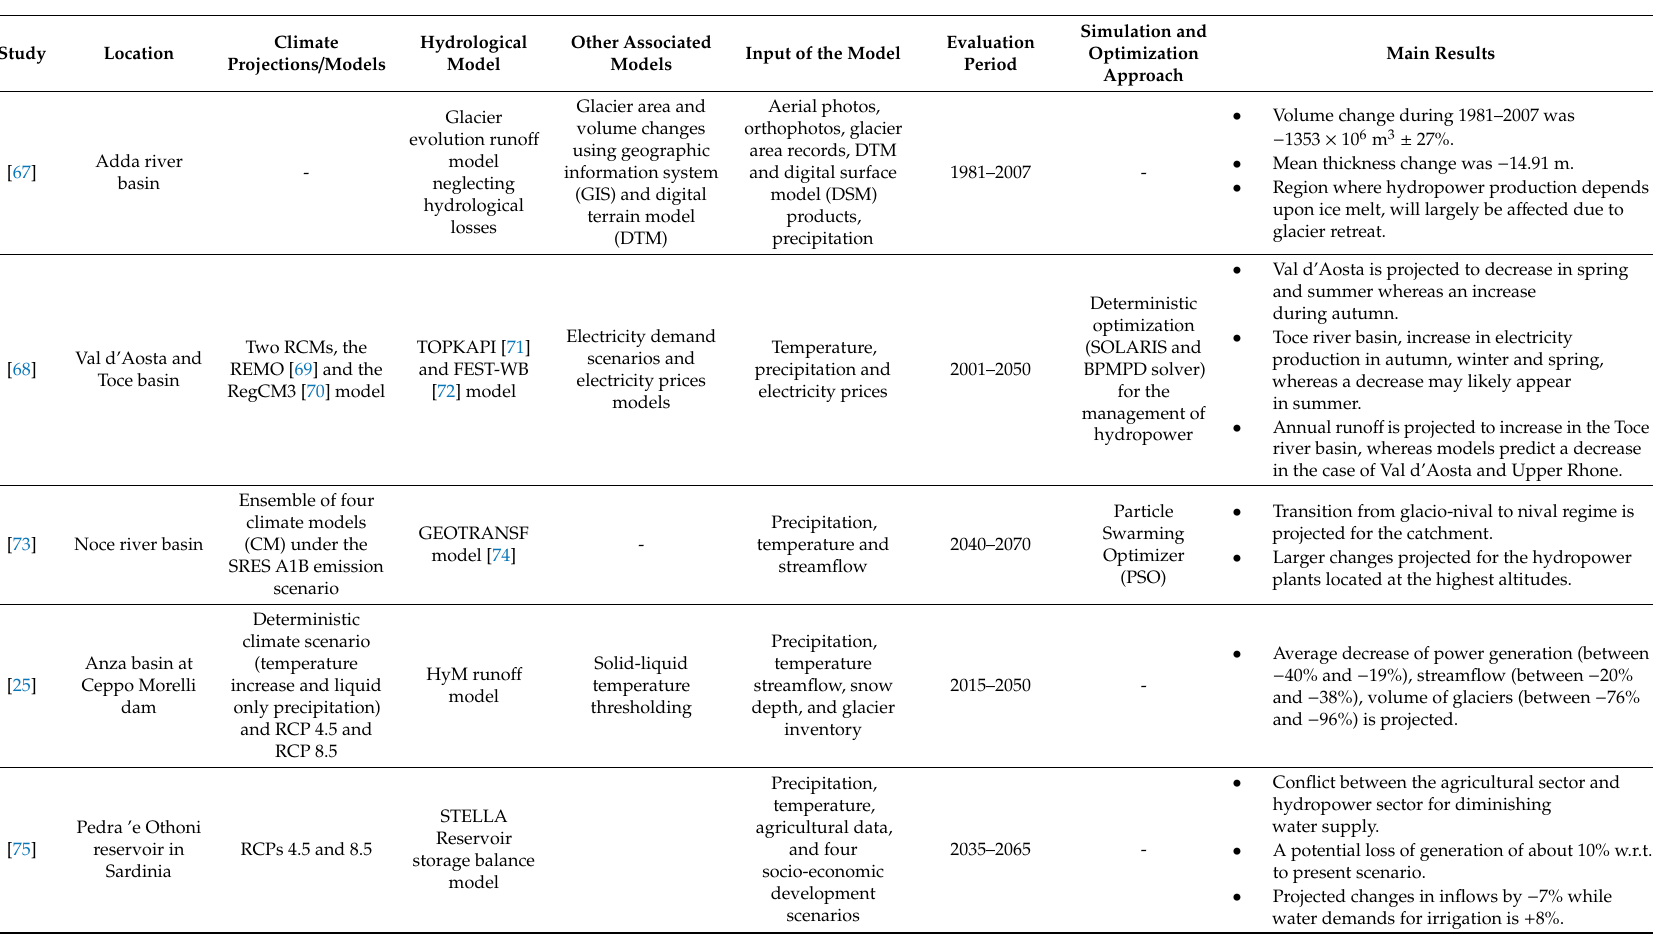
Table 2. Methodologies and main results of studies on the impacts of climate change on Italian